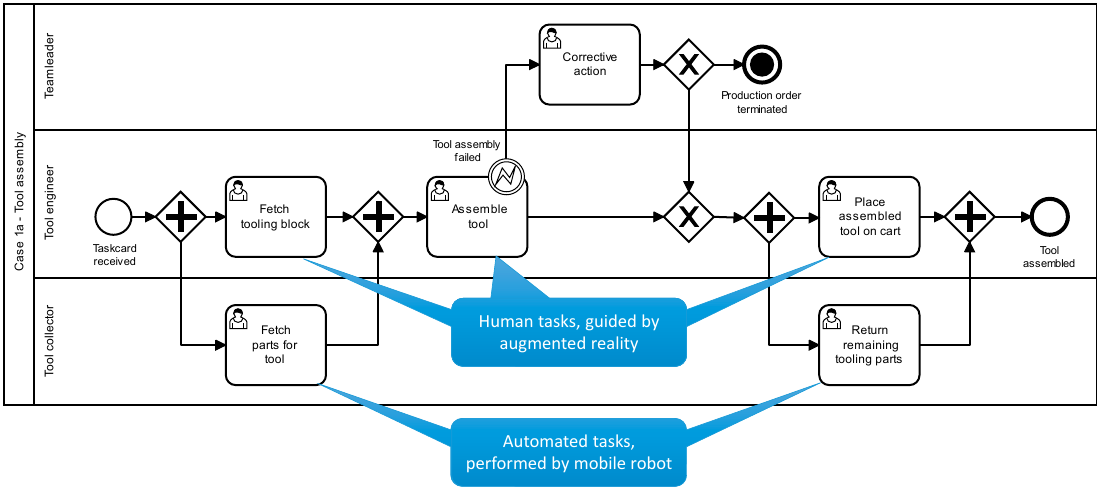
Figure 13. Process model used to enact the demonstration of Case 1a.